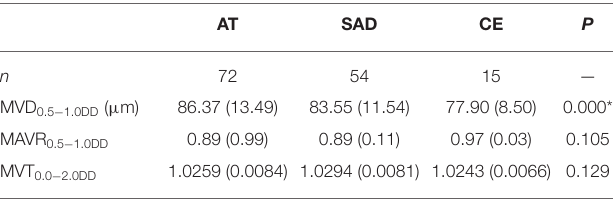
TABLE 3 | Comparison of MVD 0.5 − 1.0DD , MAVR 0.5 − 1.0DD , and MVT 0.0 − 2.0DD among AT, SAD, and CE subtypes after adjusting for clinic characteristics. AT SAD CE